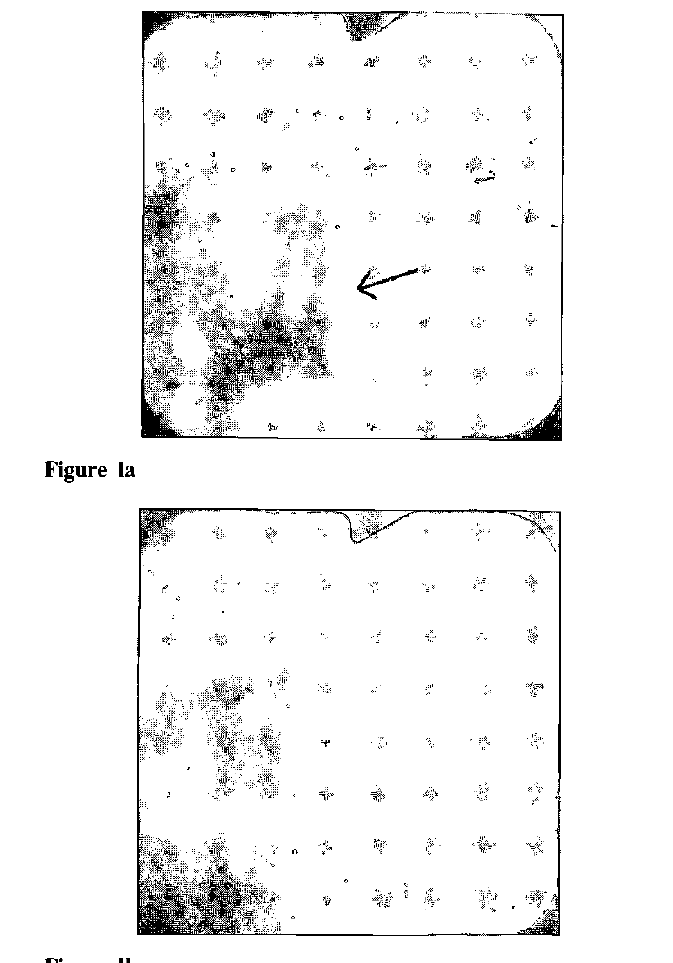
Figure la & lb. The physiological alteration of the vocal folds 'during the prolonged Ihl pre- (a) and post- (b) therapeutically.